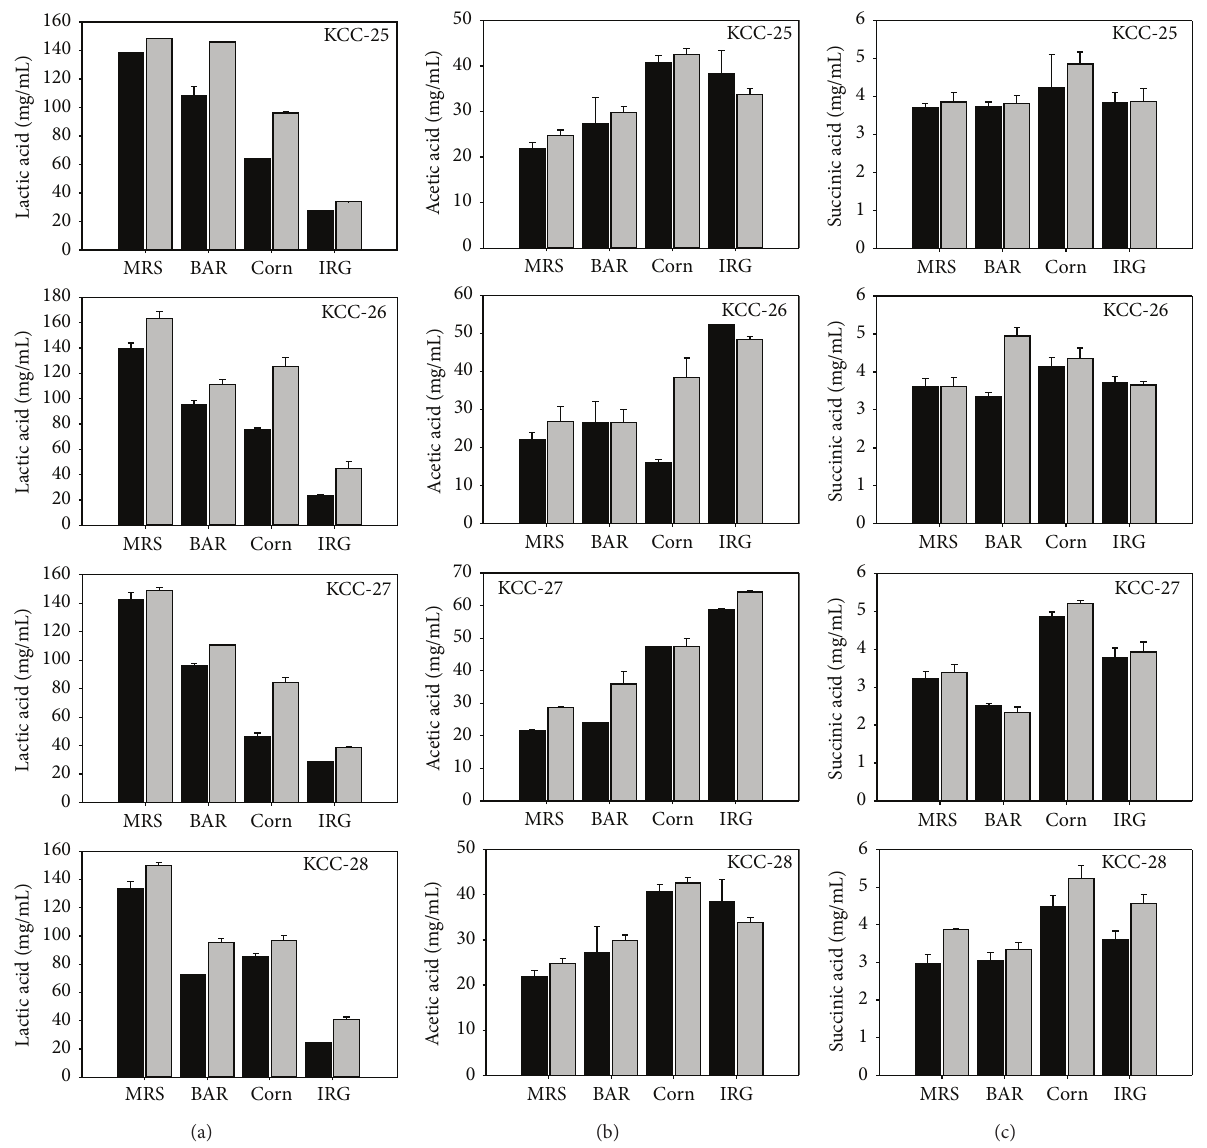
Figure 2: Fermentative metabolites of L . plantarum KCC-25, KCC-26, KCC-27, and KCC-28 in MRS broth, BAR (barley) juice, Corn juice, andIRG(Italianryegrass)juice,underaerobicandmicroaerobicconditions.(a)Lacticacid(mg/mL),(b)aceticacid(mg/mL),and(c)succinic acid